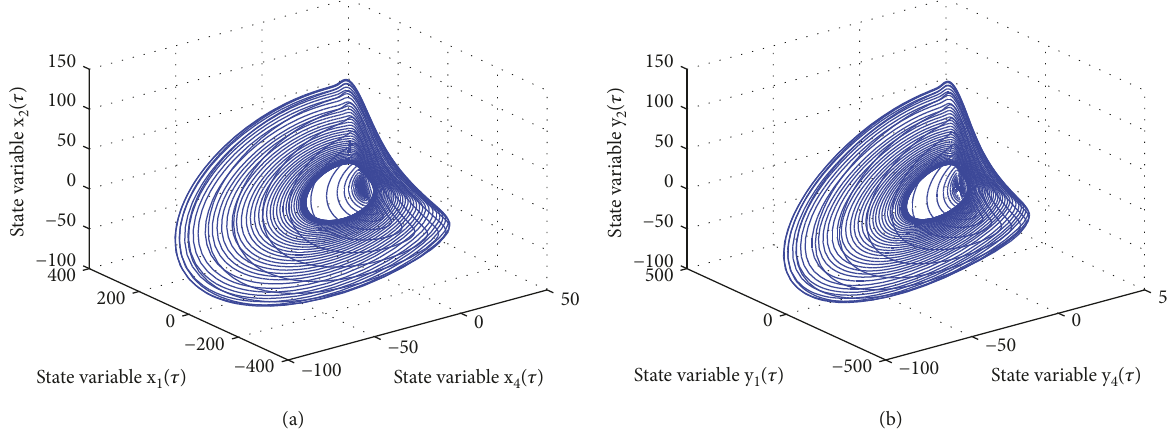
τ = arctan x τ and K derived by Proposition 2. (b) Simulation result for slave 4 4